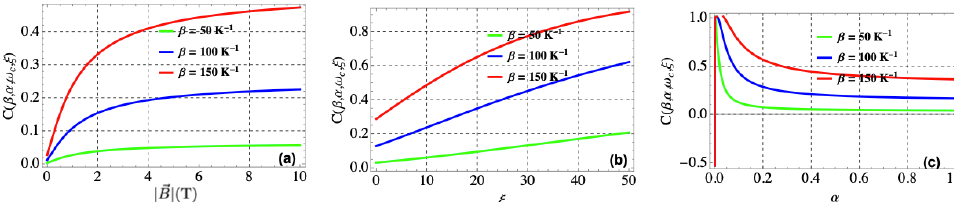
Figure 5. Specific heat capacity as a function of ( a ) magnetic field | (cid:126) B | ( T ) , ( b ) AB field ξ and topological defect α ( c ) for different values of β = 50 k − 1 (green curve), 100 k − 1 (blue curve) and 150 k − 1 (red curve); all other parameters are the same as in Figure 1.